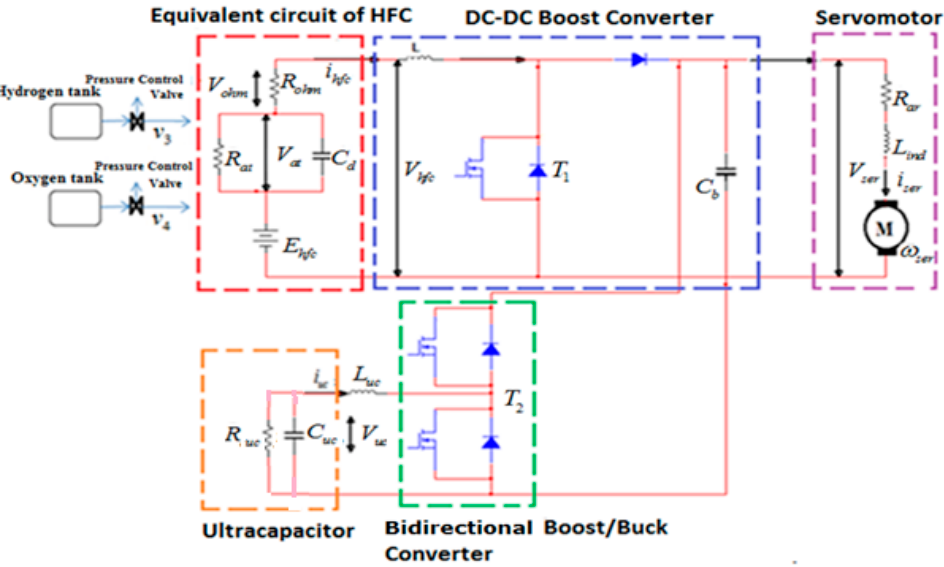
Figure 2. Equivalent circuit diagram of the Hydrogen Fuel Cell / Ultra Capacitor / Direct Current-Direct Current boost and boost / buck converter-based electric power system for hydrogen fuel cell electric vehicles.